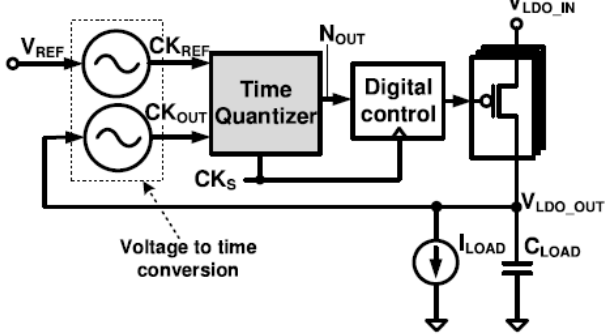
Figure 29. Beat-Frequency Quantizer and VCO-Based DLDO [56].